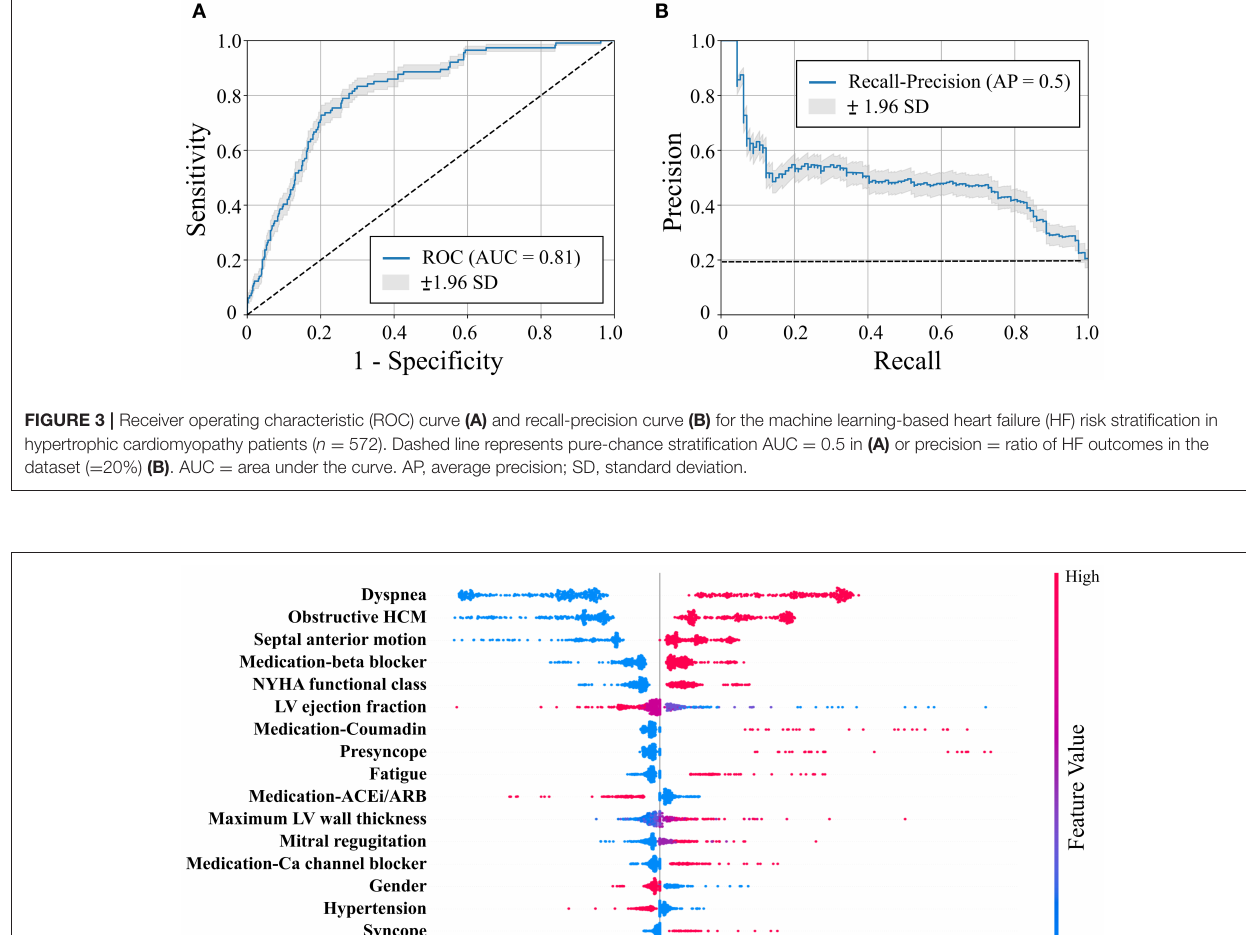
TABLE 3 | Performance evaluation of the ensemble model using the independent-validation dataset. AUC ACC Sn Sp F1 score